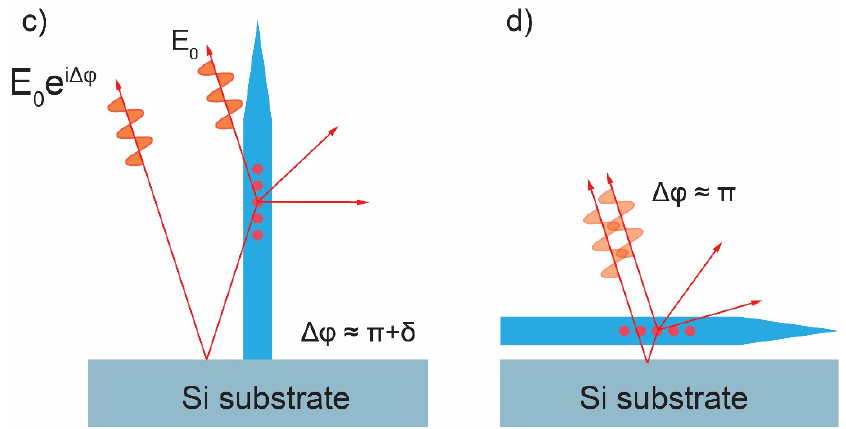
Figure 1. ( a , b ) SEM images of grown NWs on the substrate; ( c , d ) Schemes of the nanowire (shown) for standing vertically on a substrate ( c ), and lying on a substrate ( d ). The arrows illustrate the interference between the waves emitted by QD in the direction outside the substrate and reflected from the substrate.